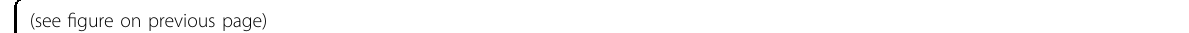
Fig. 4 Infection of ACE2 + CD14 + monocytes by SARS-CoV-2 upon TLR4/7/8 activation. a PBMCs were cultured with R848, LPS, or medium alone with or without 100 nM remdesivir for 2 h before infection. Pretreated cells were infected with SARS-CoV-2 (MOI = 1 or 3) or mock-infected for 24 h in the presence of stimuli and/or inhibitor. Flow cytometry analysis of CD14 + monocytes from mock-infected and SARS-CoV-2-infected cells showing cell surface ACE2 (Alexa Fluor 647-labeled antibody) and intracellular SARS-CoV-2 nucleocapsid (N) protein (FITC-labeled antibody). FACS channels with no staining are shown as “ empty ” . Data were collected pooled PBMCs from 3 healthy donors. Two independent infection experiments were performed with similar results. b Confocal fl uorescence microscopy of R848-stimulated PBMCs infected with SARS-CoV-2 as in a and stained with Hoechst 33342 (nuclear stain) and fl uorescent antibodies against SARS-CoV-2 N protein, CD14, and ACE2. Representative images of cells from mock and infected groups. Scale bar, 5 µm. c qRT-PCR of SARS-CoV-2 N RNA in PBMCs pretreated with R848 or medium alone for 2 h and infected with SARS-CoV-2 at MOI = 3 or mock-infected for an additional 2 h. Cells were washed then cultured with fresh medium (10% serum) for indicated time periods before RNA extraction. * indicates comparisons between 0 h and other time points for R848-treated groups with viral infections. # indicates comparison of R848-treated and untreated groups with viral infections at the same time points. * or # , P < 0.05; ** or ## , P < 0.01. d qRT-PCR of SARS- CoV-2 sgRNA in the cells as treated in c . e Flow cytometry of cell surface ACE2 and intracellular SARS-CoV-2 N protein in CD14 + monocytes from PBMCs cultured with R848 or medium alone with or without 2 µg/mL anti-ACE2 antibody or goat IgG control, 50 µM camostat mesylate, or 2% DMSO (vehicle) for 2 h and then infected with SARS-CoV-2 at MOI = 3 or mock-infected for 24 h in the presence of stimuli and/or antibody/inhibitor. f Percentage of ACE2 + CoV-2 N + monocytes in antibody- or inhibitor-treated groups compared to control groups. Each dot represents pooled PBMCs from 3 healthy donors. Two independent infection experiments were performed with similar